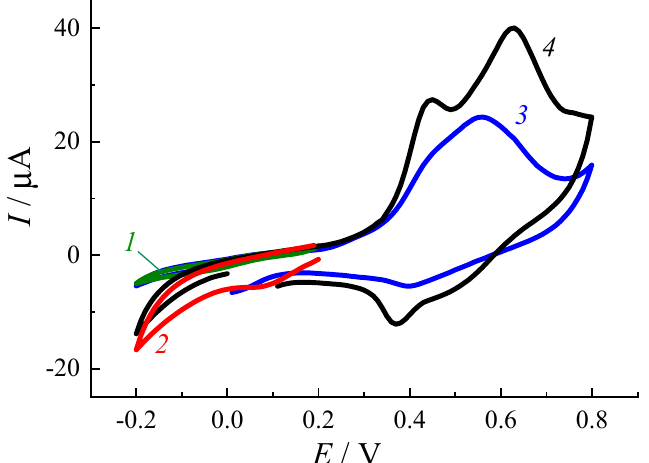
Figure 11. CV curves obtained in buffer (pH 7) at 20 mV/s from (1, 3) SPE/GO and (2, 4) SPE/TiO 2 modified by 3 µL CuI-PPy (drop coating) at different anodic limits: 1, 2—0.2 V; 3, 4—0.8 V, respec- tively.